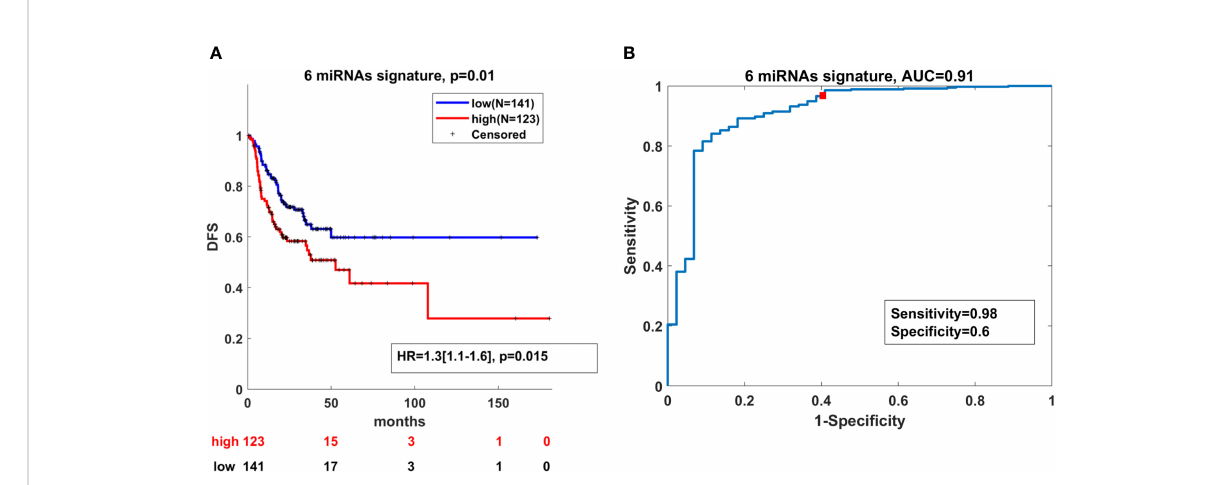
FIGURE 5 High expression of the miRNA signature correlates with lower DFS and can distinguish OSCC from normal cases. (A) Kaplan – Meier analysis representing the correlation between expression levels of the miRNA signature and DFS in OSCC patients from the TCGA cohort. The TCGA cohort was divided in two subgroups according to high and low mean expression levels of each miRNA. High and low subgroups were established by evaluating positive and negative z-scores of the mean expression values of the miRNAs, respectively. For each KM curve, the hazard risk, con fi dence interval, and relative p-value (p) of the multivariate Cox analysis are also indicated. Cox regression was adjusted for T, N stage and HPV status. (B) Diagnostic ability of the miRNA signature for OSCC. ROC curve analysis of the miRNA signature in discriminating between patients and healthy individuals from the TCGA